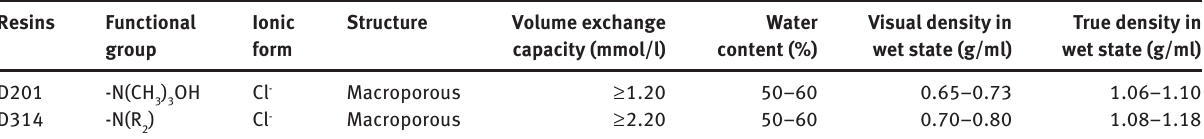
Table 2: The chemical and structural properties of D201 and D314 resins. Resins